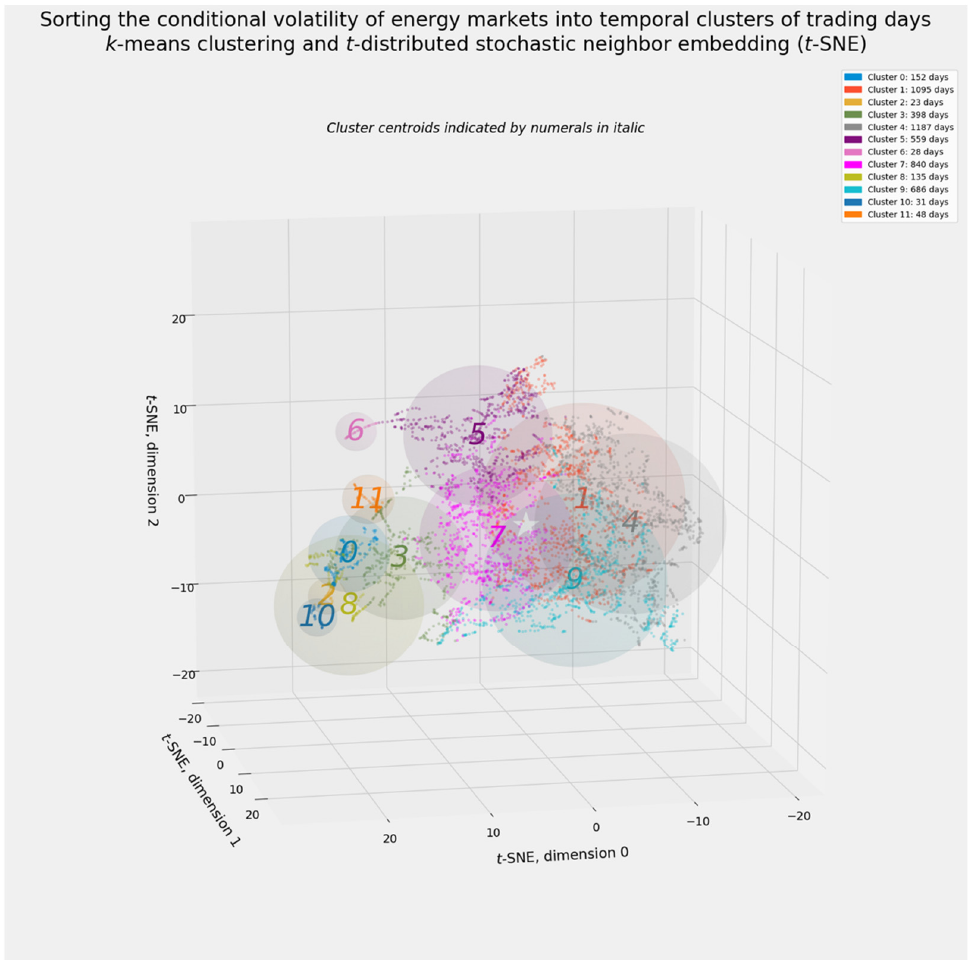
Figure 33. k -means clustering of energy-related markets—A t -SNE manifold.